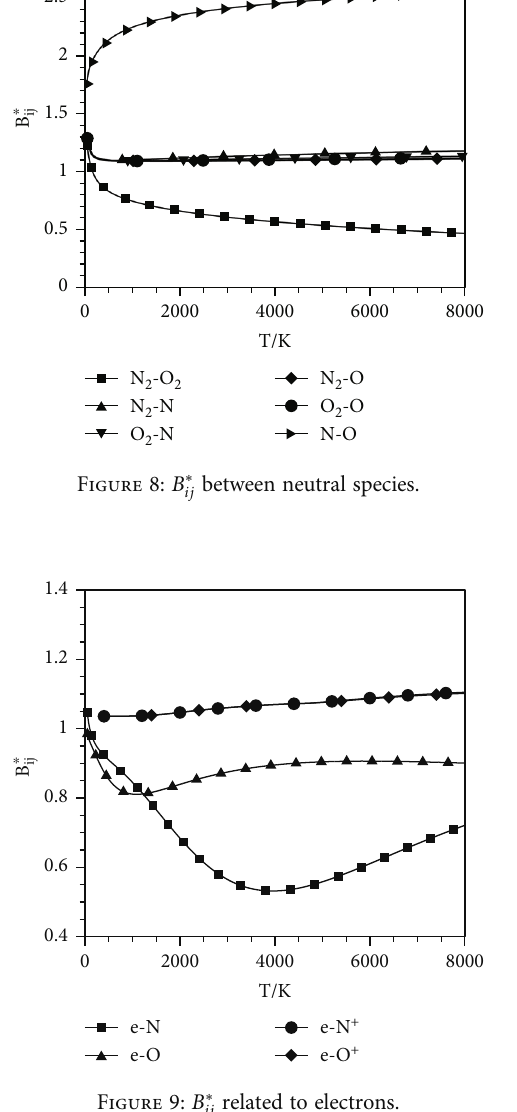
Figure 9: B ∗ ij related to electrons.